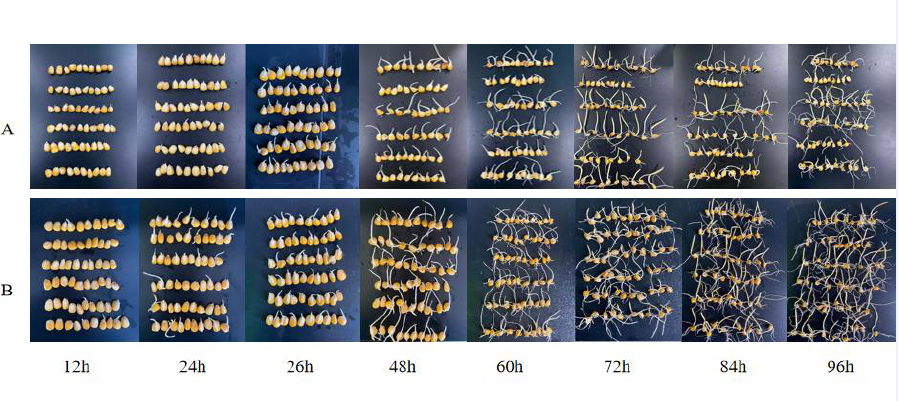
Figure 1. Different stages of germinated maize. ( A ) Control group. ( B ) Ultrasound group.